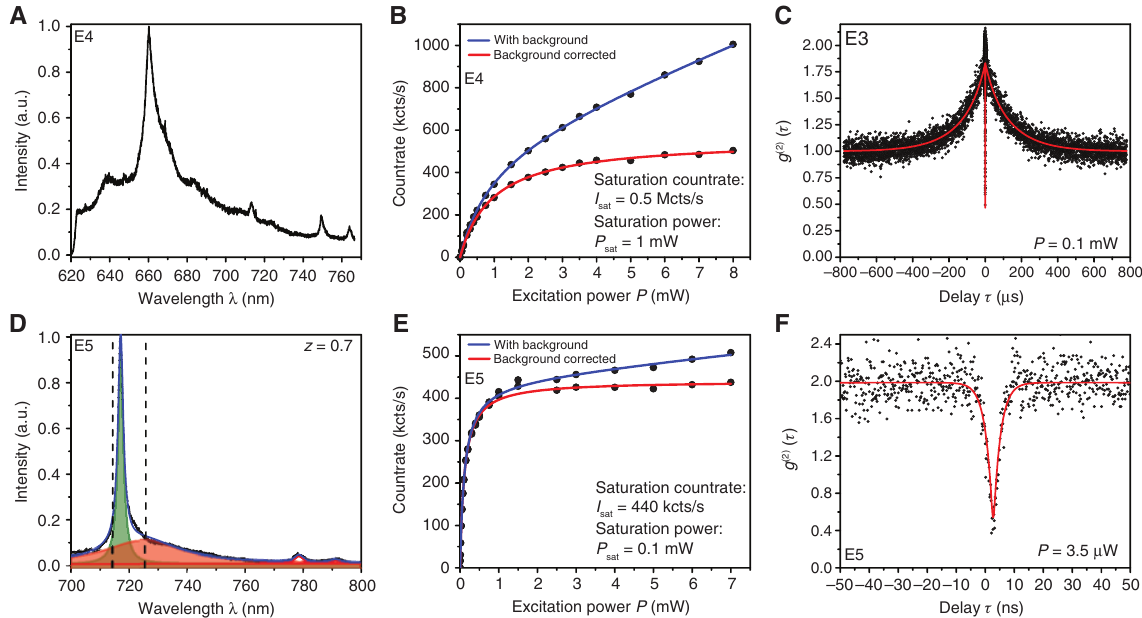
Figure 2: Photoluminescence spectra and single photon emission from individual defects in hBN with strong and vanishing background emission, respectively. (A) Spectrum of an emitter in hBN (E4) with a clear background contribution. (B) Saturation measurement on the emitter in A. The background contribution is visible as prominent linear increase in the emission rate at increasing excitation powers. (C) g (2) -function on an hBN emitter (E3) showing typical bunching timescales of several hundreds of microseconds. (D, E, F) Spectrum, saturation measurement and g (2) -function of an emitter (E5) with a clean spectrum. Background contribution becomes relevant at about 20 × P limited even at almost vanishing excitation